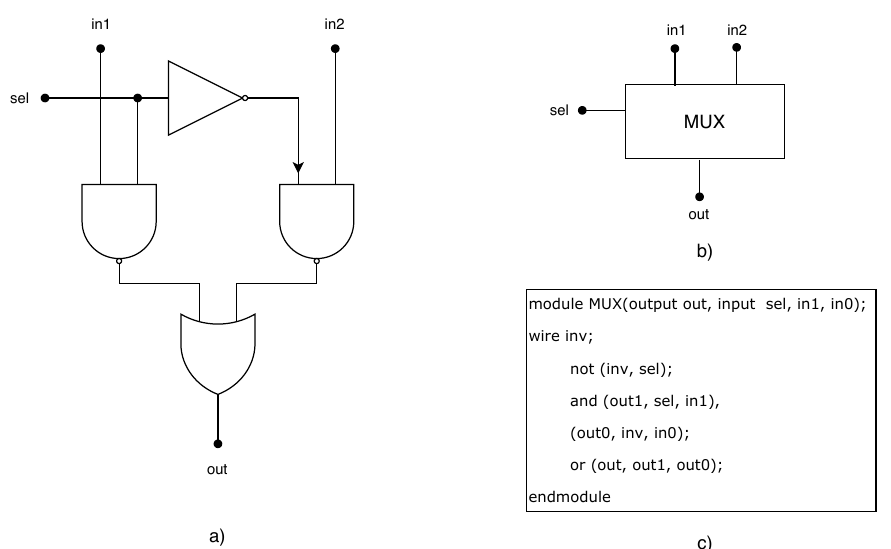
Figure 1. An example of a selection circuit showing the logic schematic for the elementary selector ( a ), the logic component for MUX ( b ), and the structural description in Verilog ( c